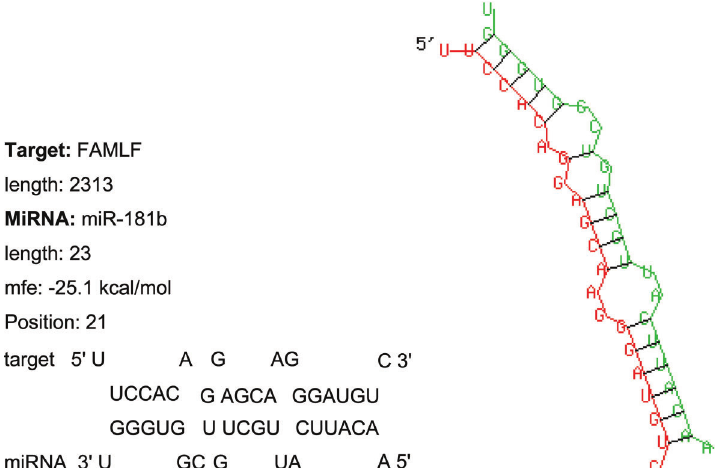
Figure 1. miR-181b target site prediction for FAMLF by the RNAhybrid program. miR-181b bound with bases 21 – 42 of the FAMLF 5 0 un- translated region in an incomplete complemen- tary